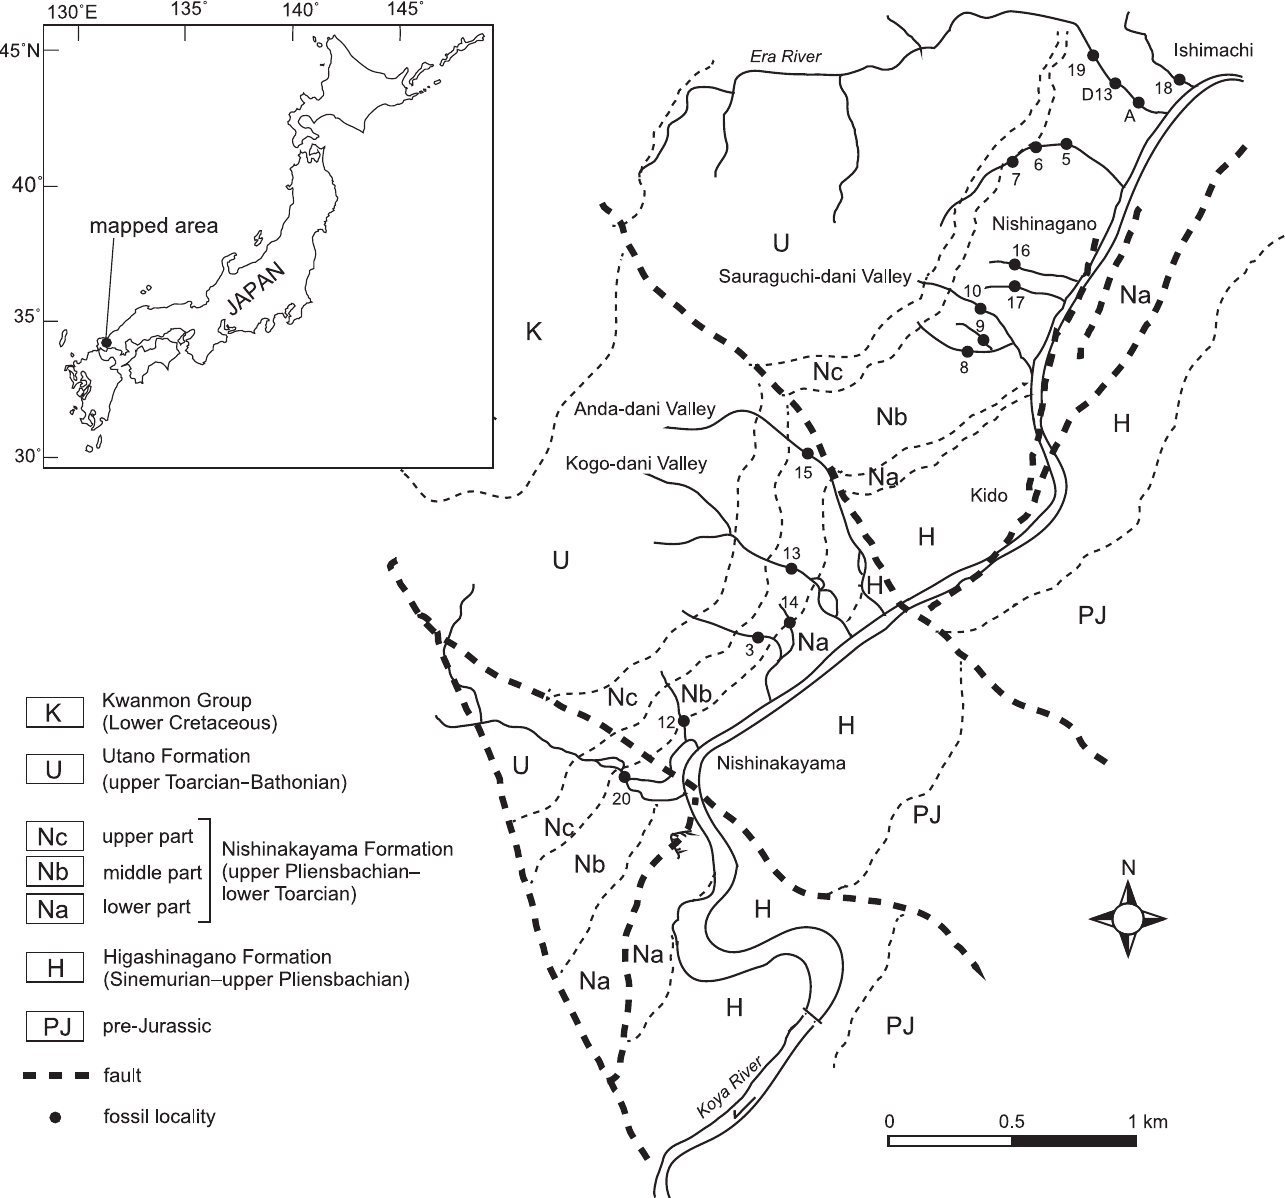
Fig. 2. Geological map of the Toyora area, southwest Japan (modified from Tanabe et al.